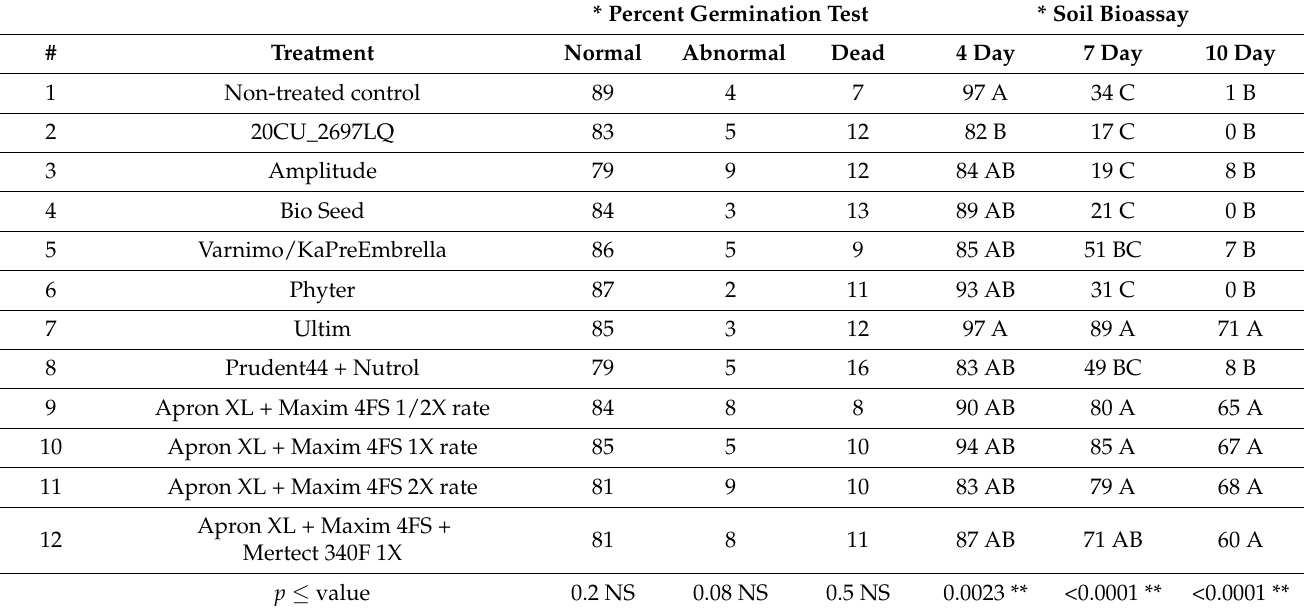
Table 4. Percent germination test results (Normal seedlings, Abnormal seedlings and Dead) and Soil Bioassay results for percent viable seedlings (4 Day, 7 Day, 10 Day). * Percent Germination Test * Soil